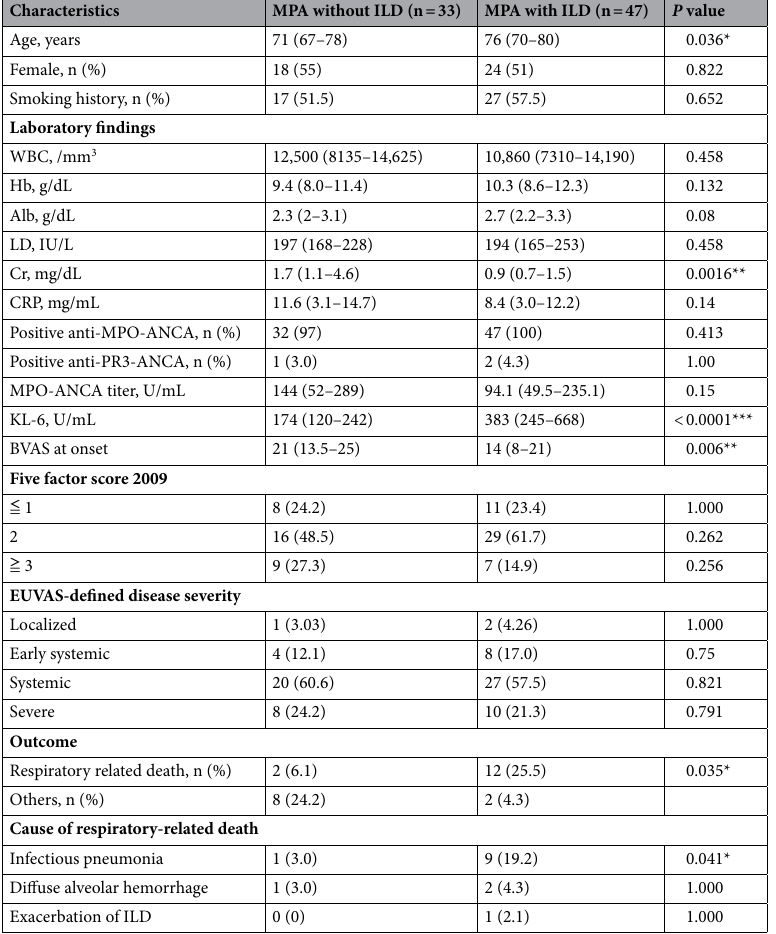
Table 2. Comparison of clinical characteristics, and outcomes of patients between MPA with or without ILD. The laboratory markers are presented as the median (interquartile range). The P-values were estimated using Fisher’s exact test or Wilcoxon rank sum test. MPA microscopic polyangiitis, ILD interstitial lung disease, WBC white blood cell, Hb hemoglobin, Alb albumin, LD lactate dehydrogenase, Cr creatinine, CRP C-reactive protein, MPO-ANCA myeloperoxidase-anti-neutrophil cytoplasmic autoantibody, PR3-ANCA proteinase 3-anti-neutrophil cytoplasmic antibody, KL-6 Krebs von den Lungen-6, BVAS Birmingham Vasculitis Activity Score, EUVAS European Vasculitis Study Group. *P < 0.05, **P < 0.01, ***P <